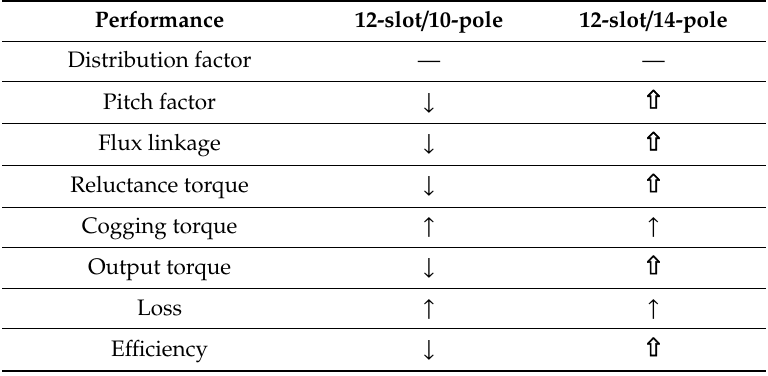
Table 4. Comparisons of performance with the modular structure.